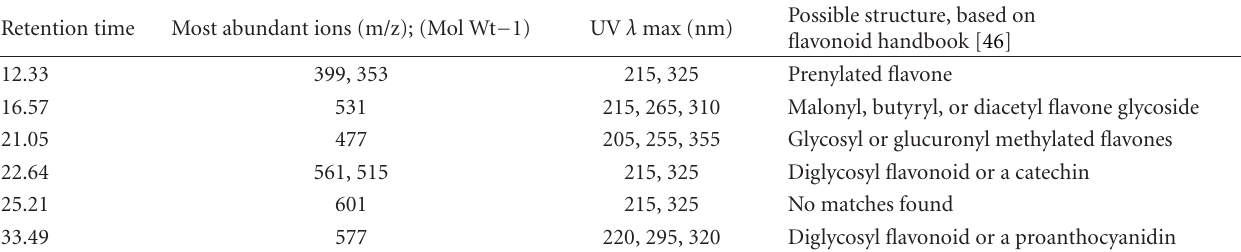
Table 1: Molecular weight and UV data obtained for GKW components using LC-MS and LC-UV. Reversed phase gradient HPLC chromato- graphy with UV and negative ion mass spectral detection was performed as described in Section